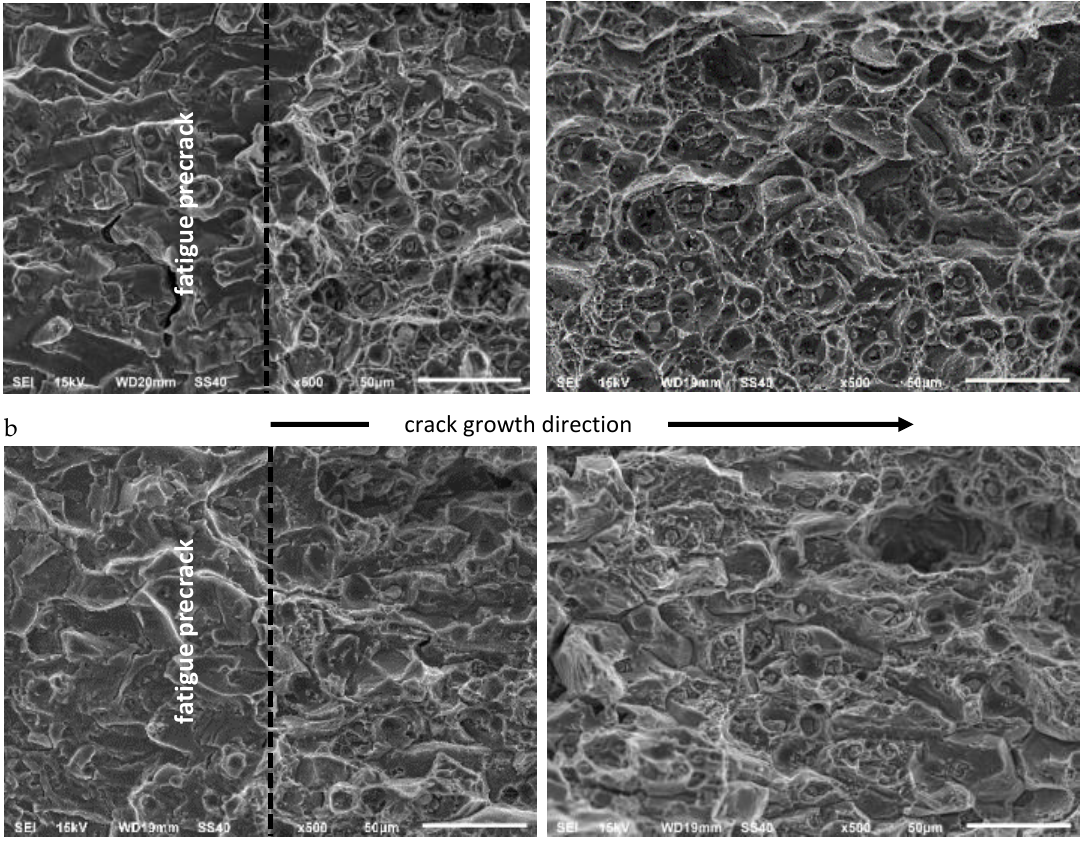
Figure 10. A comparison of fracture surfaces of CT specimens made of AA2519 aluminum alloy at 293 K ( a ) and at 77 K ( b ).